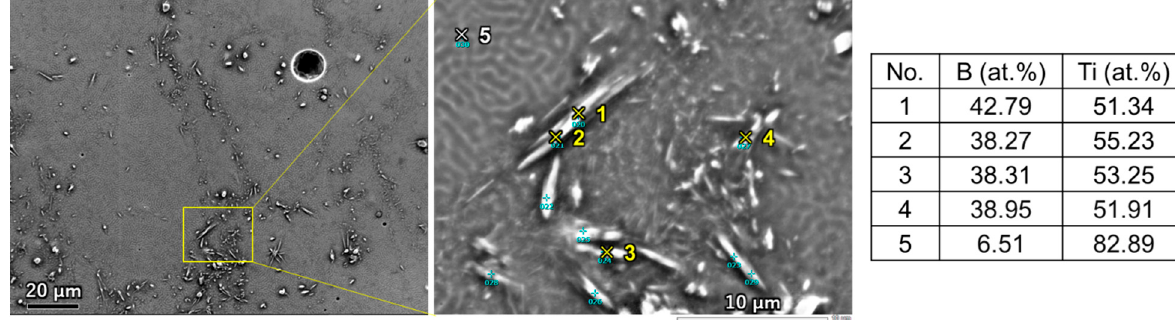
Figure 5. EDS analysis of SLM Ti64- ( a ) 1 and ( b , c ) 5 mass% TiB 2 alloys: (-1) inside prior β -grains and (-2) on prior β -grain boundaries.